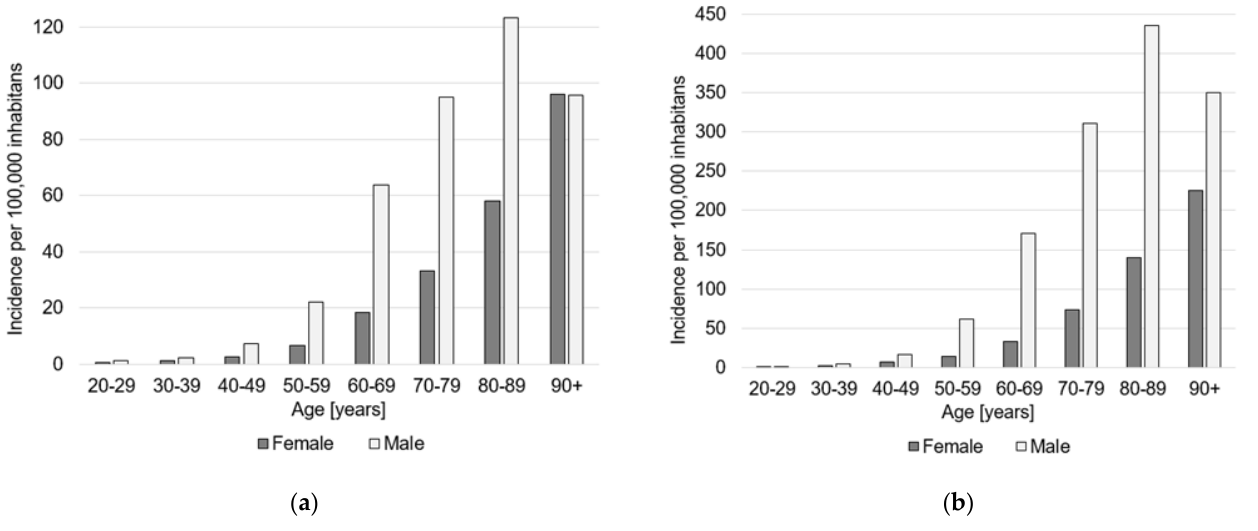
Figure 1. Age and sex adjusted incidence rates per 100,000 inhabitants for the year 2019. ( a ) Major amputations, ( b ) minor amputations. Female cases are shown in dark grey and male cases in light grey.